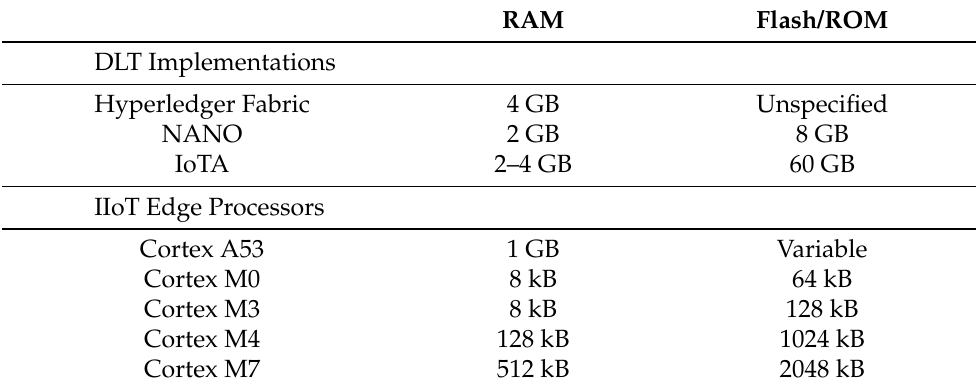
Figure 10. Limited cell reception forces community members to travel kilometres to be closer to cell towers (circled in red) in order to conduct online activities. ( a ) Supervisor searches for a stable cell signal in order to attend student’s online MSc defense session; ( b ) Members of the community seek shelter from the summer sun after traveling to the cell tower in order to participate in online university activities. Table 2. DLT installation requirements versus IIoT edge node